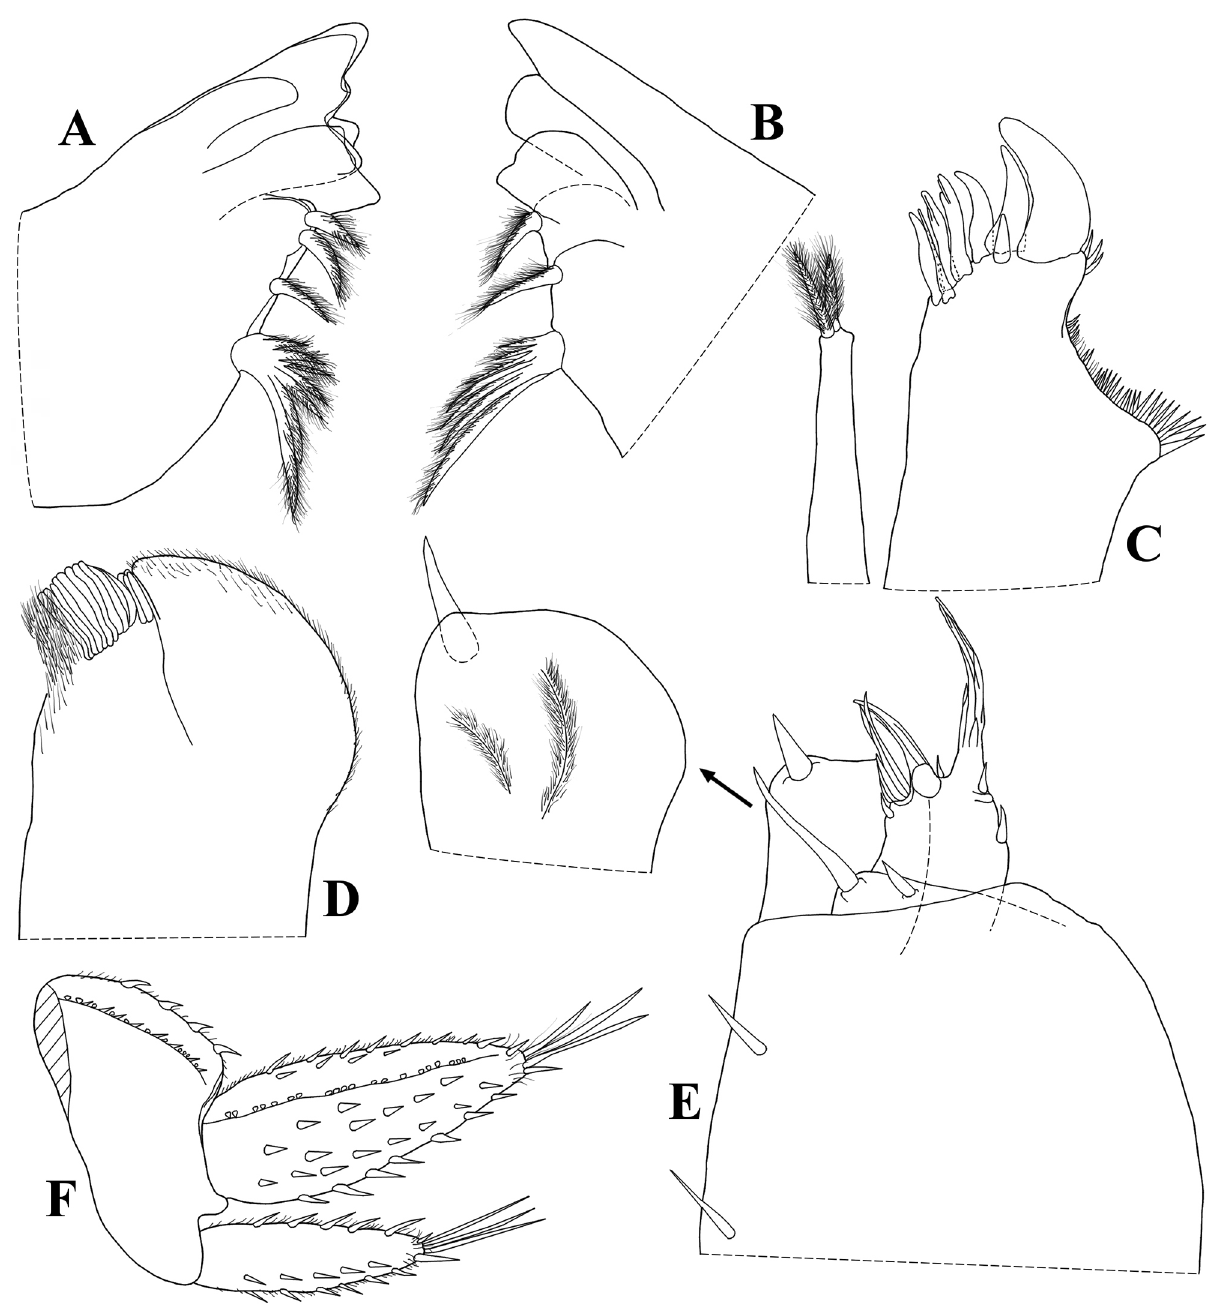
Figure 2. Trichorhina navasi López-Orozco, Carpio-Díaz and Campos-Filho n. sp. (male paratype). A , left mandible; B , right mandible; C , maxillula; D , maxilla; E , maxilliped; F ,